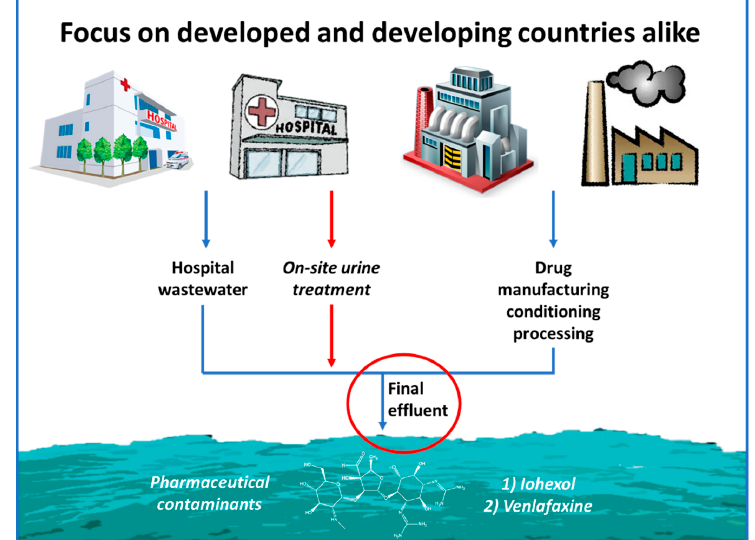
Figure 6. Schematic representation: Treatment of hospital and highly concentrated flows of PhACs.